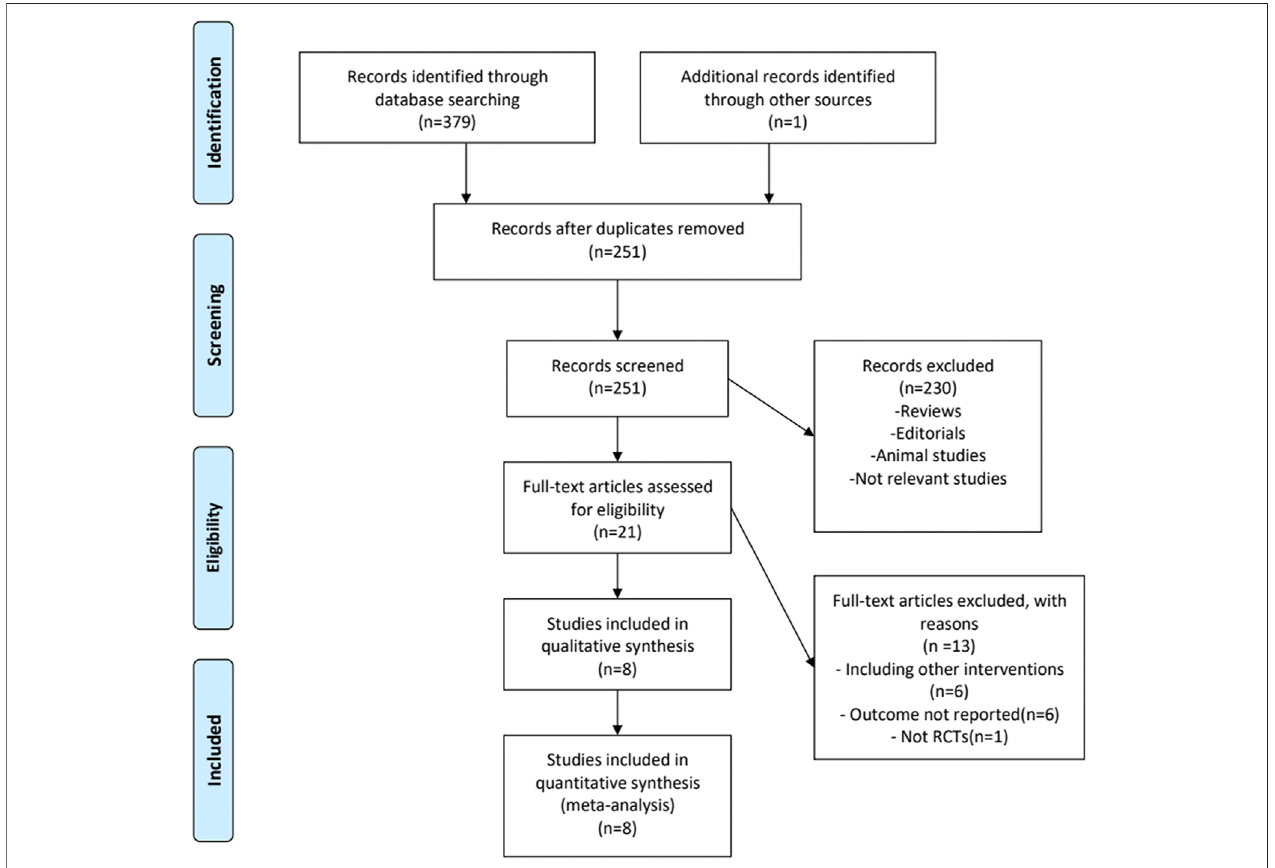
FIGURE 1 | Flowchart of database search and study identi fi